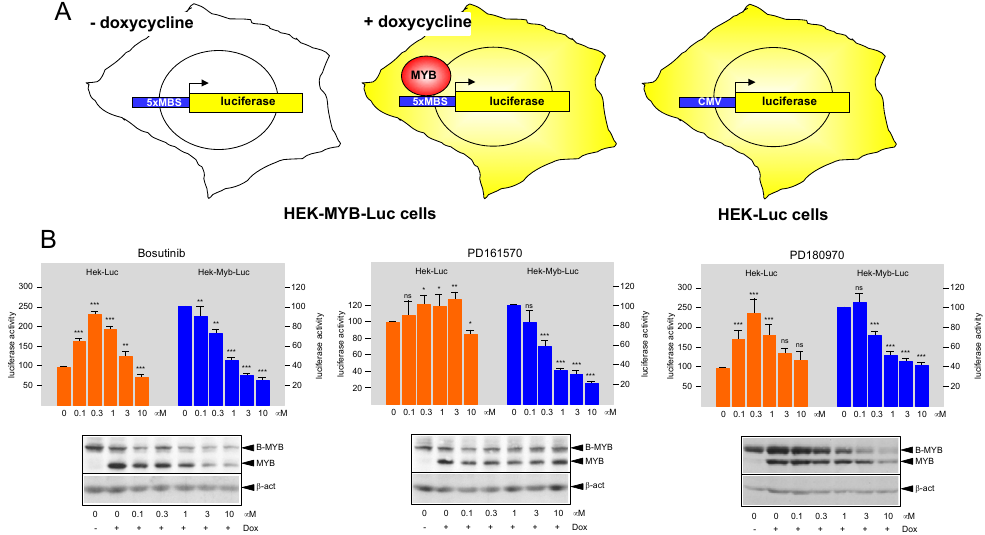
Figure 1. MYB inhibitory activity of selected protein kinase inhibitors. ( A ) Schematic illustration HEK-MYB-Luc and HEK-Luc cells. HEK-MYB-Luc cells carry a stably transfected artificial MYB-inducible luciferase reporter gene and a doxycycline-inducible expression system for human MYB-2KR. HEK-Luc cells carry a constitutively active luciferase expression vector. ( B ) HEK-Luc and HEK-MYB-Luc cells were treated for 16 h with Bosutinib, PD161570, and PD180970 at the indicated concentrations. Bars show the average luciferase activity of the cells relative to cells treated only with doxycycline. The bottom panels show the expression of MYB, B-MYB (cross-reacting with the anti-MYB antibody) and β -actin. Asterisks indicate statistical significance (ns: not significant; * p < 0.05; ** p < 0.01; *** p < 0.001; Student’s t